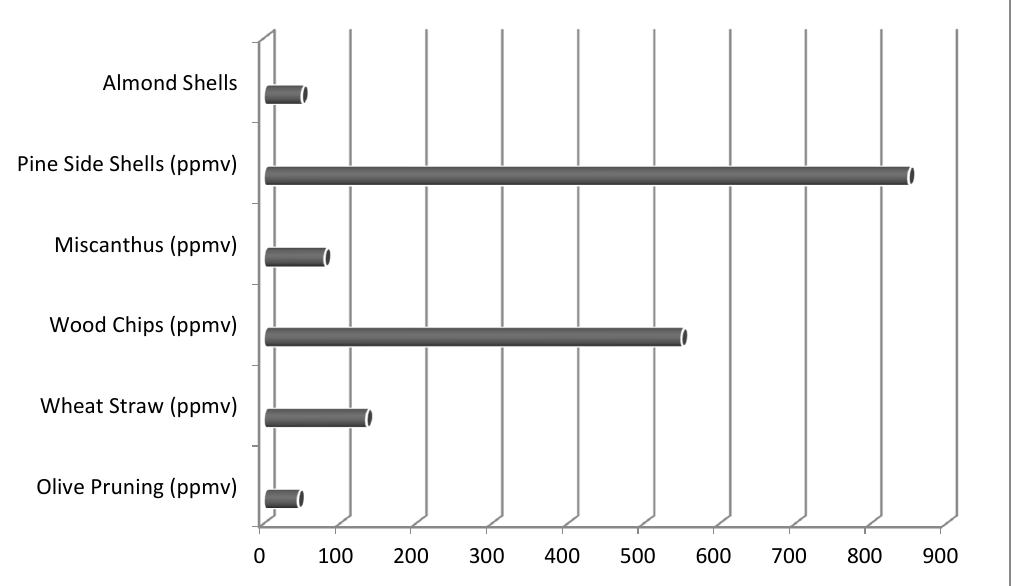
Figure 1. Predicted HCl level in the “Güssing” gasifier [63].